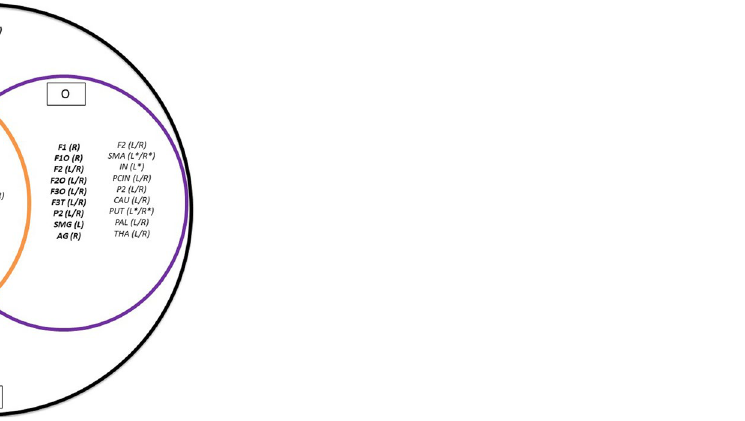
Figure 11. Central nodes in the β - and γ-hierarchical level of the multiplex network. The coloured circles are associated to the rules as follows: orange = S ( β) ; violet = O ( β) ; black = T ( γ) , and in each circle the brain regions acting as local central nodes are reported. In the intersections are the brain regions acting as intermediate multiplex central nodes. The asterisks indicate overlapping brain regions between the intermediate (β) and the highest (γ) hierarchical level. In bold are the in-strength central nodes. Notice that: ( a ) only in the black circle are localized brain regions that do not appear in the intermediate hierarchical level; ( b ) overlapping brain regions of the α—level disappear in the